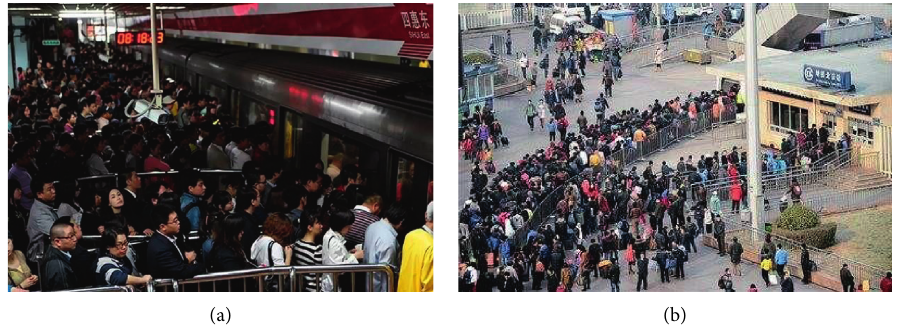
Figure 1. The left-behind and controlled passengers in different area. (a) Left-behind passengers at the platform. (b) Controlled passengers at the